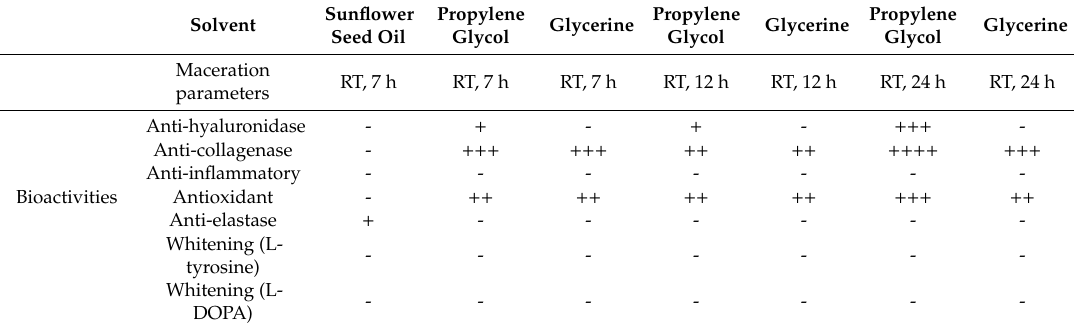
Table 4. Bioactivities of various R. nigrum pomace extracts obtained by conventional and ultrasound- assisted maceration in propylene glycol, glycerine, and sunflower seed oil.